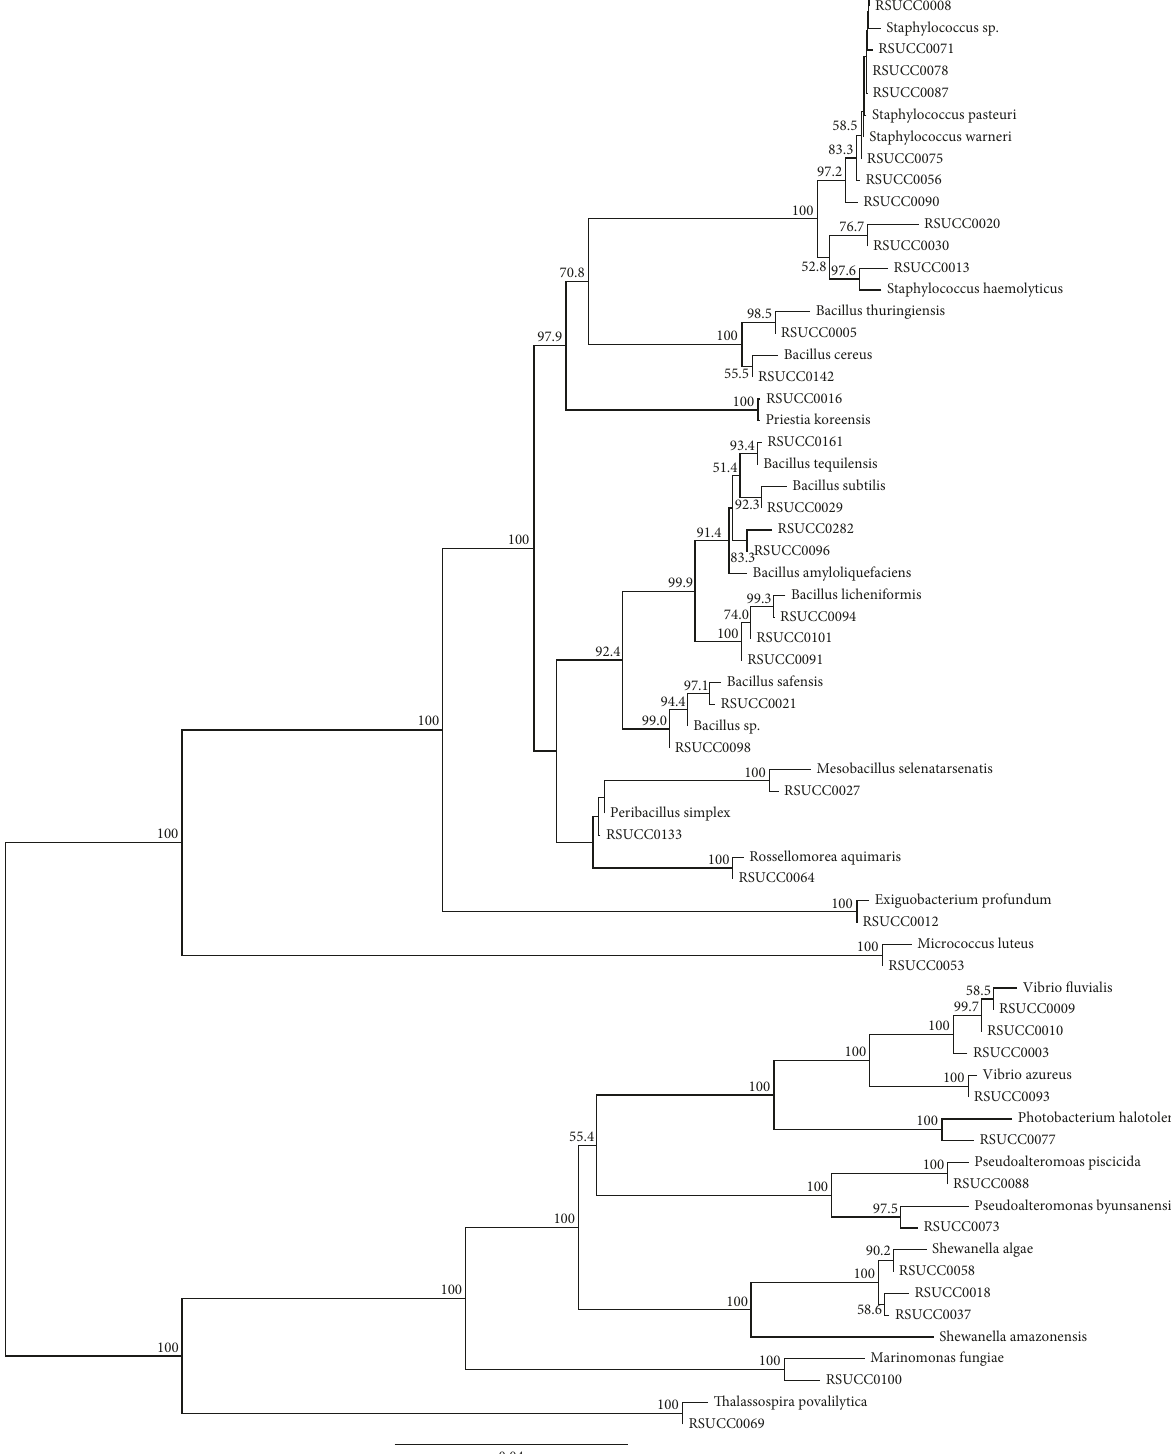
Figure 1: Phylogenetic tree constructed from 16S rRNA gene fragments of 40 isolated bacterial strains together with known close evolutionary relationship bacterial